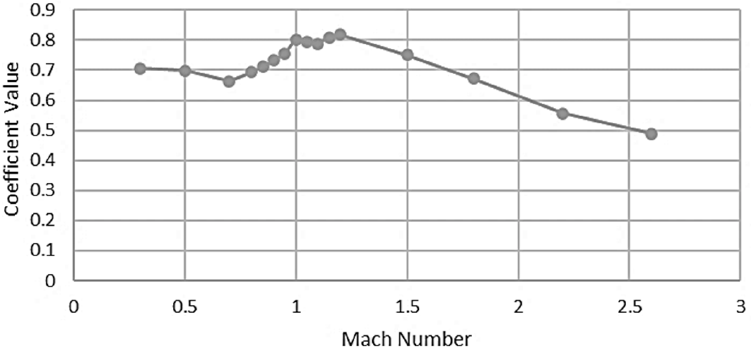
Figure 12. Mach number vs lift coefficient for an angle of attack of 2.4 degrees.